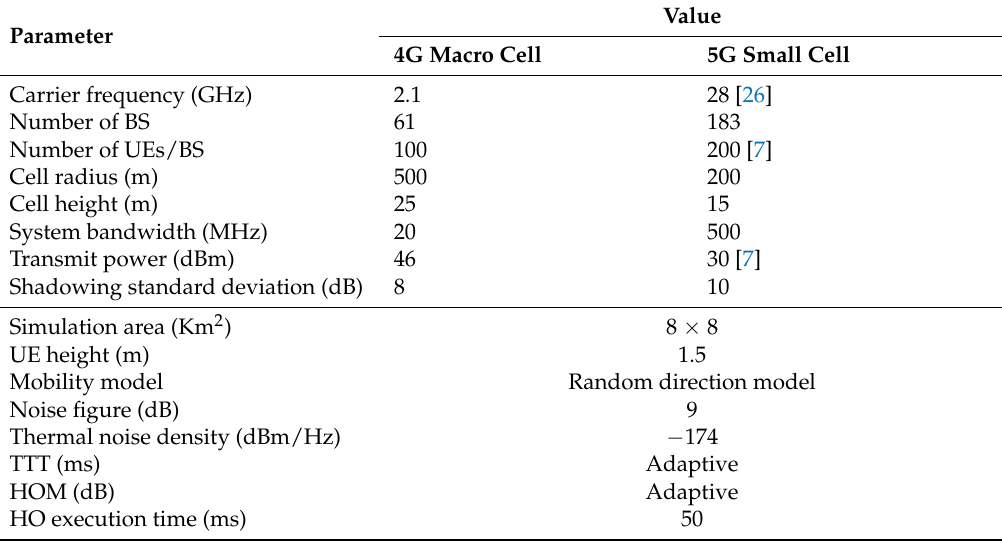
Table 3. Simulation